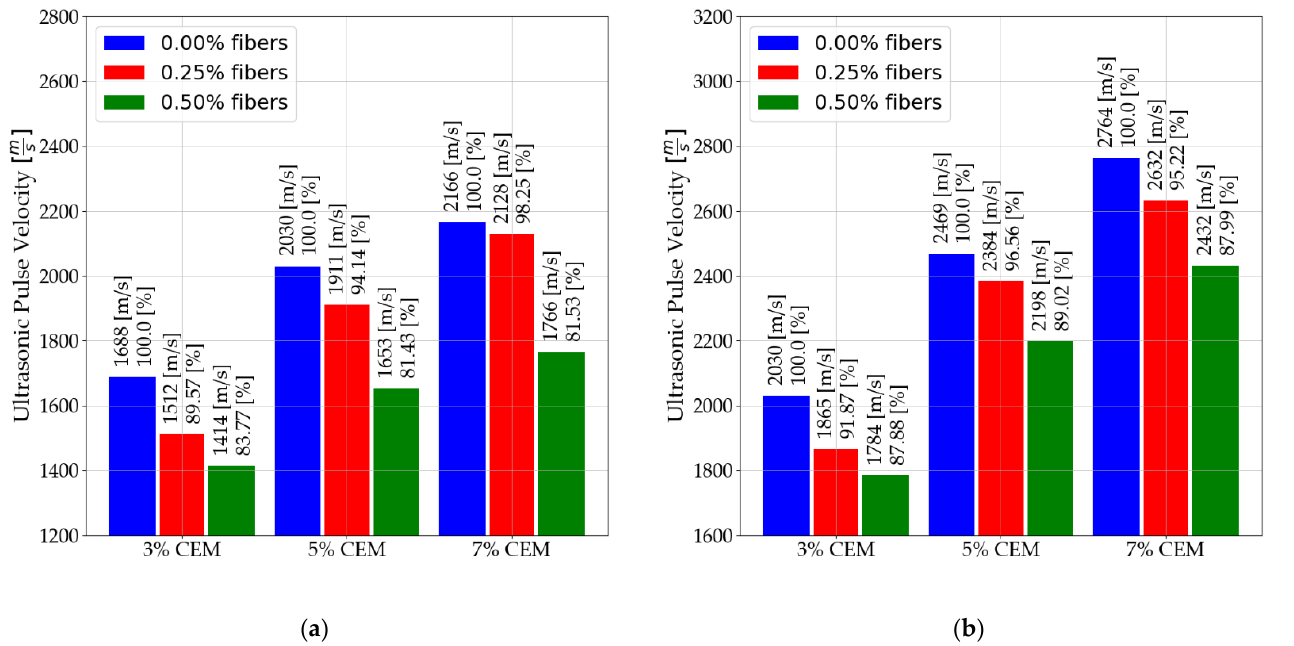
Figure 5. Ultrasonic pulse velocity: ( a ) after 7 days of mixture curing; ( b ) after 28 days of mixture curing.